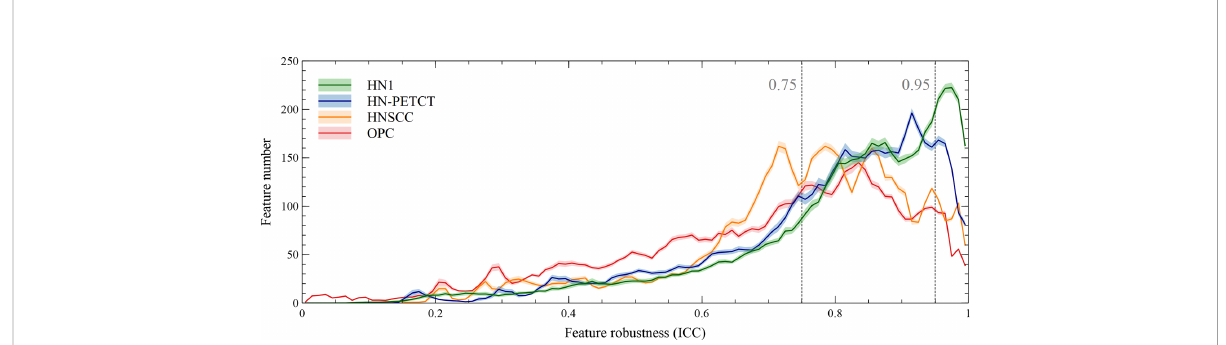
FIGURE 2 Histograms of the robustness of all the extracted radiomic features for the four analyzed datasets averaged under cross-validations. Feature robustness is quanti fi ed as intraclass correlation coef fi cient (ICC). The shaded areas indicate the 95% con fi dence interval of the average histogram curves. In general, there are more high-robust features than ones with low robustness. Different datasets show distinctive patterns of feature robustness distributions. HN1 and HN-PETCT have more features with high robustness, whereas HNSCC and OPC have the histograms skewed towards the lower